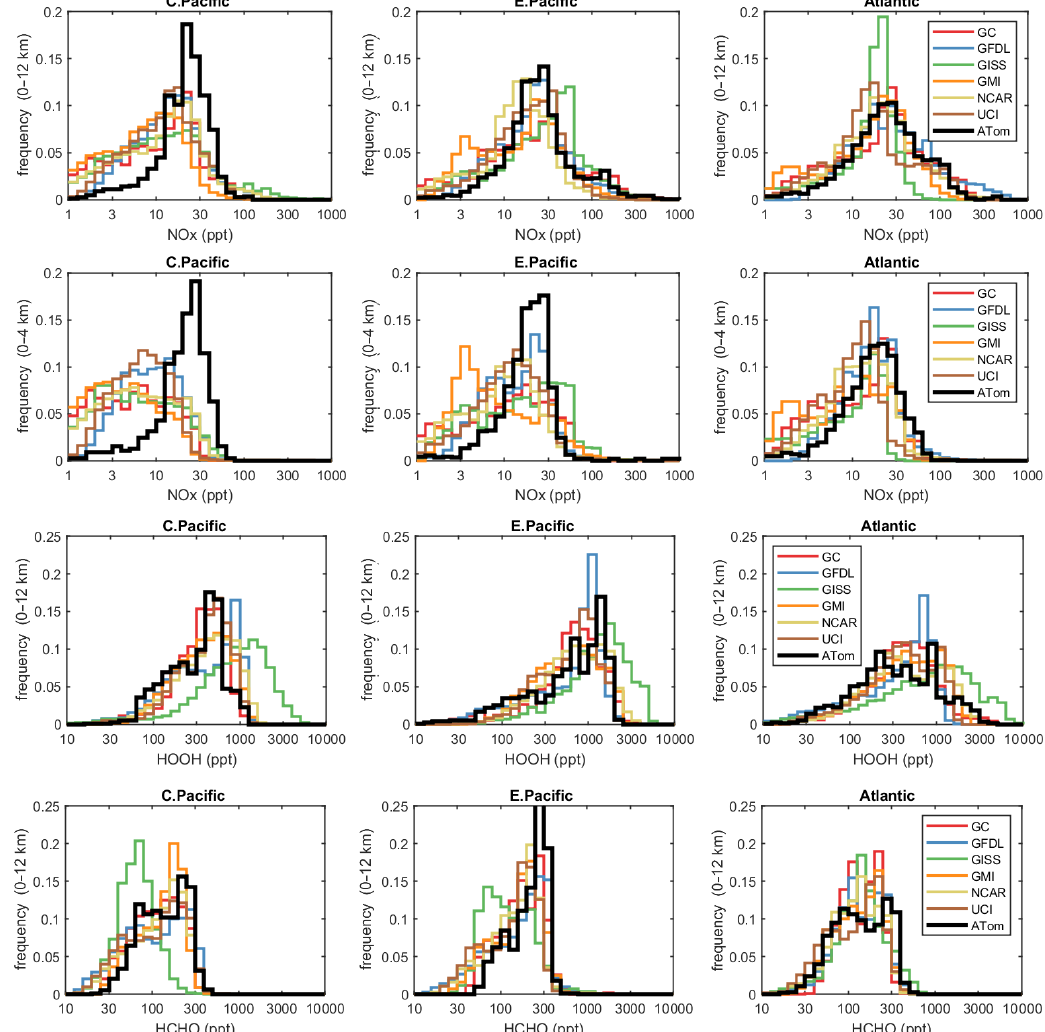
Figure 4. Histograms of probability densities (PDs) of NO x (0–12km, row 1), NO x (0–4km, row 2), HOOH (0–12km, row 3) and HCHO (0–12km, row 4) for the three tropical regions (central Pacific, eastern Pacific, Atlantic). The ATom-1 data are plotted on top of the six global chemistry models’ results for a day in mid-August and sampled as described in Fig.